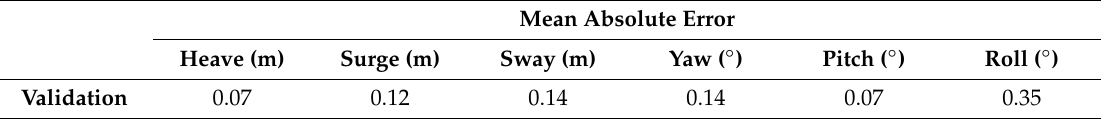
Table 12. Mean absolute error (MAE) for each of the six degrees of freedom studied in the validation of the transfer